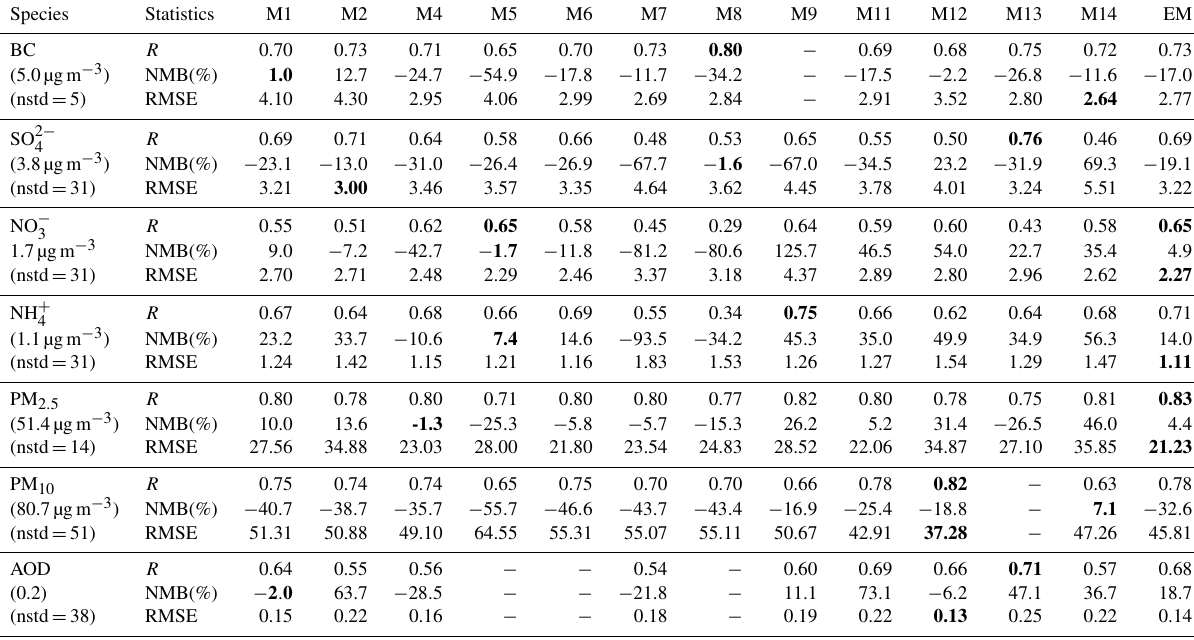
Table 2. Statistics of BC, SO 2 − , NO − , NH + , PM 2 . 5 , PM 10 , and AOD. Best results are in bold. Monthly mean observations and the number 4 3 4 of stations (nstd) are in italic. In this table, monthly measurements except BC are taken from EANET, CNEMC, and AERONET. Monthly BC concentrations are collected from published literature.